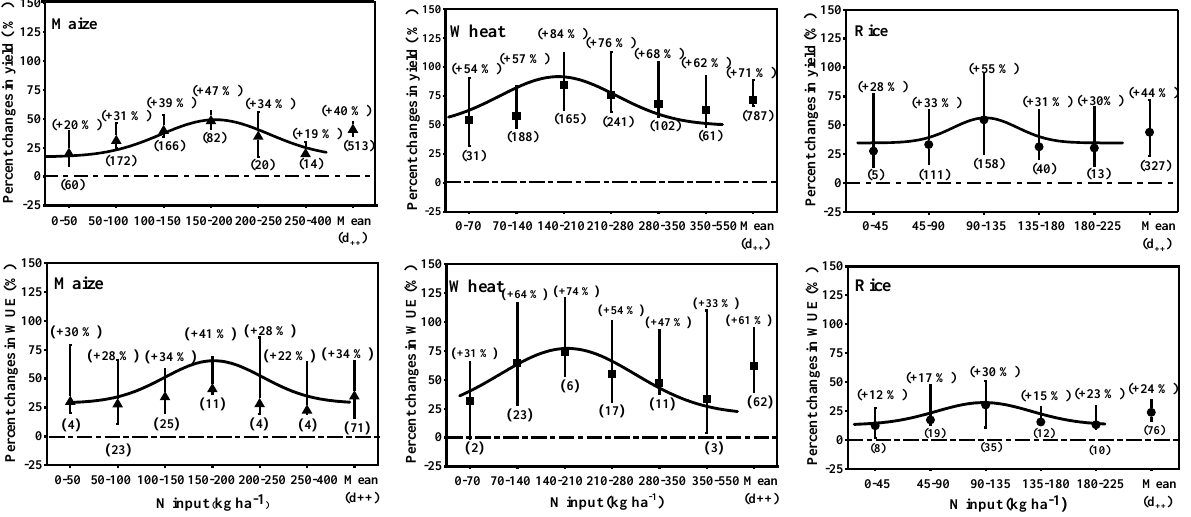
Figure 3. Percent changes in crop yield and WUE according to N input (kg ha −1 ), expressed as the mean value with bias-corrected 95% confidence intervals. Percentage change and observation numbers for each group are given in parentheses. The solid lines are fitted by non-linear regression model to percent changes datasets. Triangles represent field experiment of maize, squares represent field experiment of wheat, and circles represent field experiment of rice.